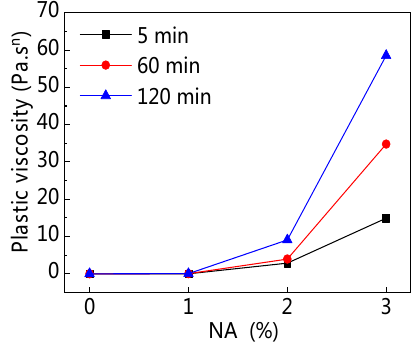
Figure 26. Influence of NA on K .